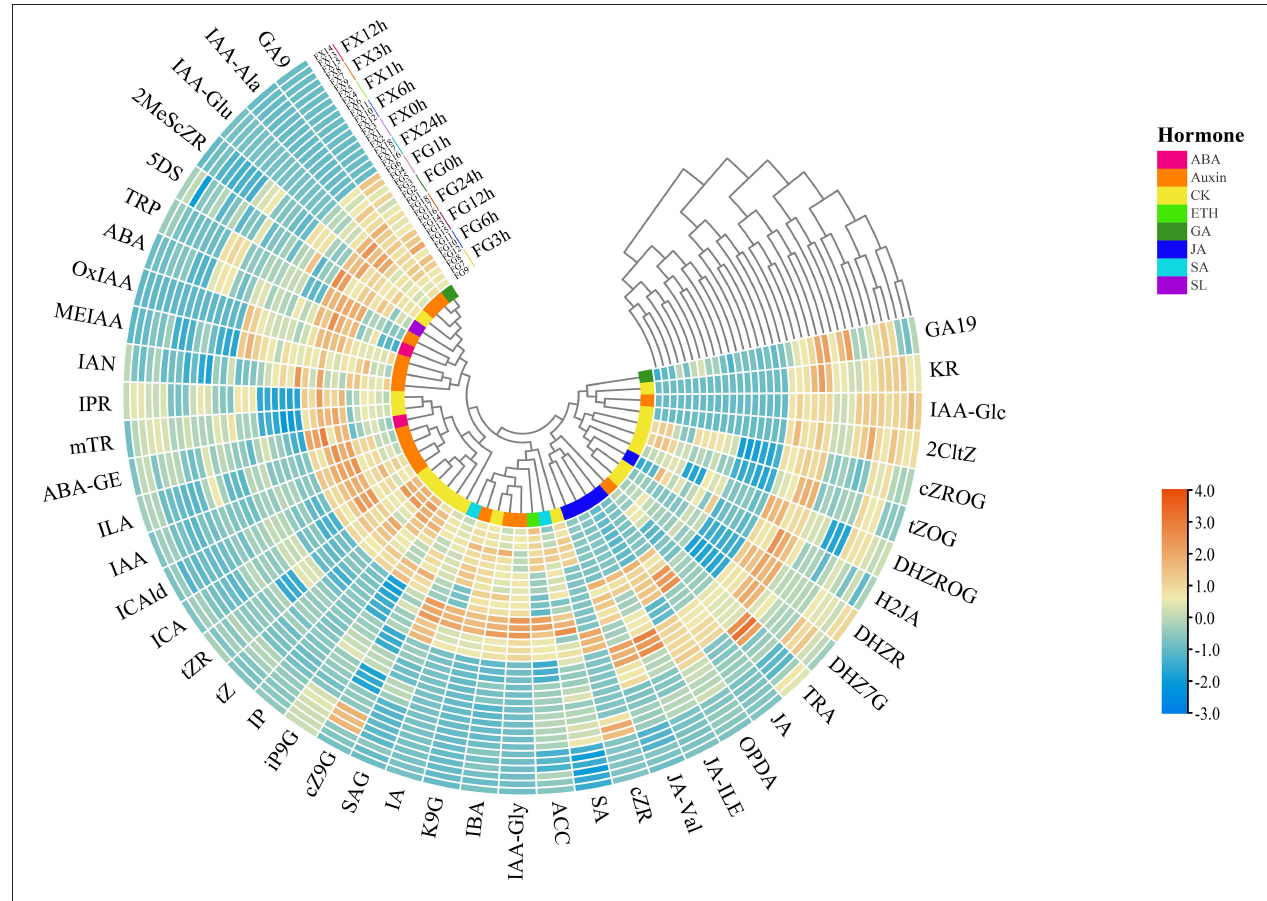
FIGURE 2 | The cluster heat map of the plant hormone components for Z. bungeanum varieties FG and FX.